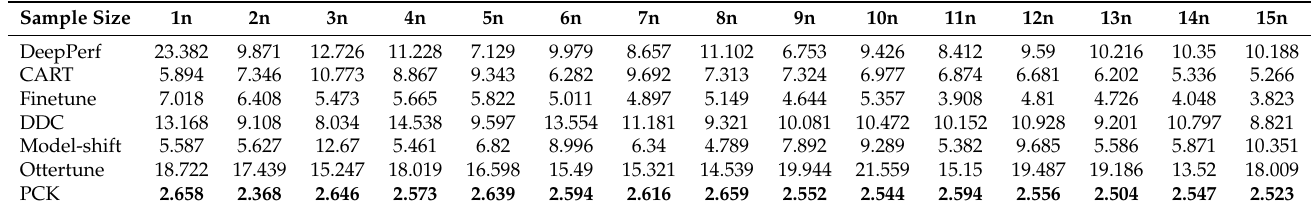
Table 7. MRE comparison among different approaches for MySQL (version 5.5–5.7). Sample Size